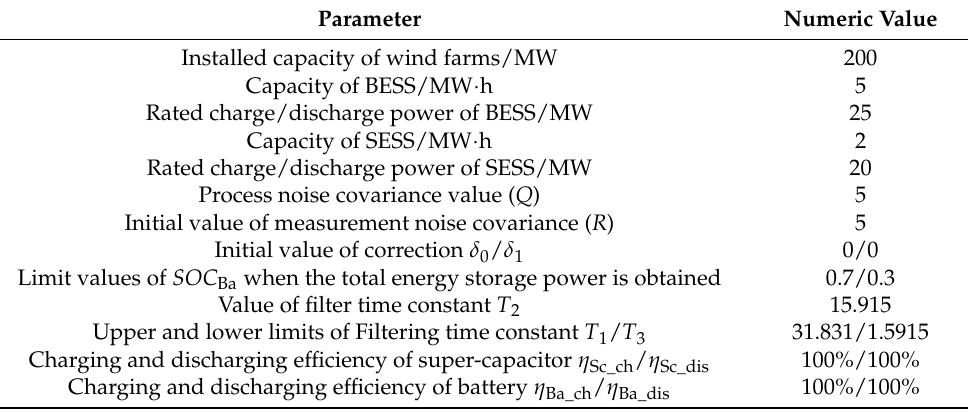
Table 2. Simulation parameters. Parameter Numeric